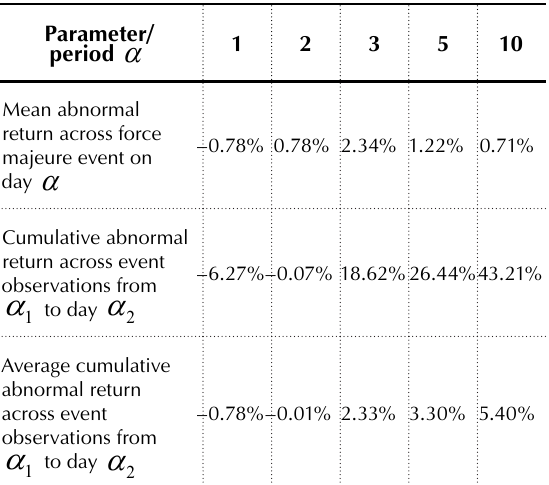
Table 6. Cumulative abnormal returns for the PFST returns over the period 1991–2018: social force majeure and terrorist